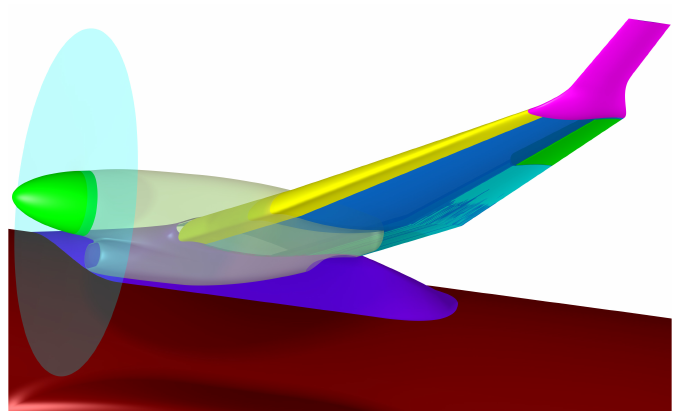
Figure 10. CAD surfaces of the Reference Aircraft (RA) wing with an optimal morphing droop nose.